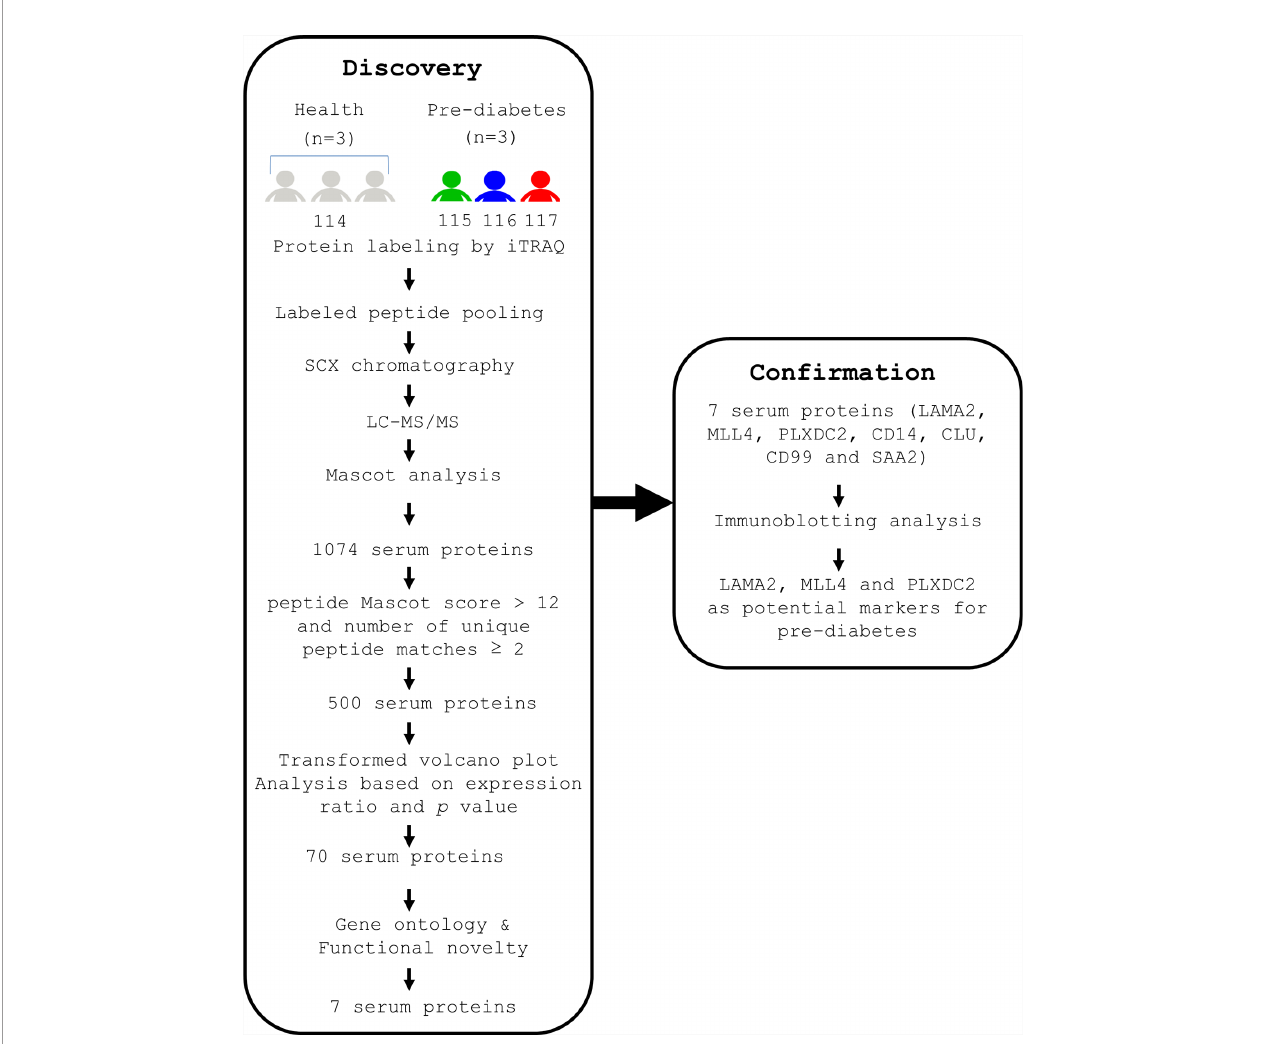
FIGURE 1 | A fl ow chart indicating the experimental designs for identi fi cation of serum proteins of human origin, followed by con fi rmation of their presence in human sera. Serum samples were collected from 3 healthy volunteers and 3 pre-diabetic patients after fasting for 12 h. The serum from the 3 healthy subjects was pooled together and labeled with iTRAQ 114. The serum from 3 pre-diabetic subjects was labeled with iTRAQ 115, 116 and 117, respectively. In the fi rst step (Discovery stage), the iTRAQ-labeled sera were pooled, depleted of serum abundant proteins, and subjected to MS analysis. As a result, 1074 serum proteins were identi fi ed. Seven serum proteins were selected from 1074 proteins by using average relative protein ratio, P value and novelty. In the second step (Con fi rmation stage), immunoblotting analysis showed that 3 out of the 7 serum proteins are promising markers for